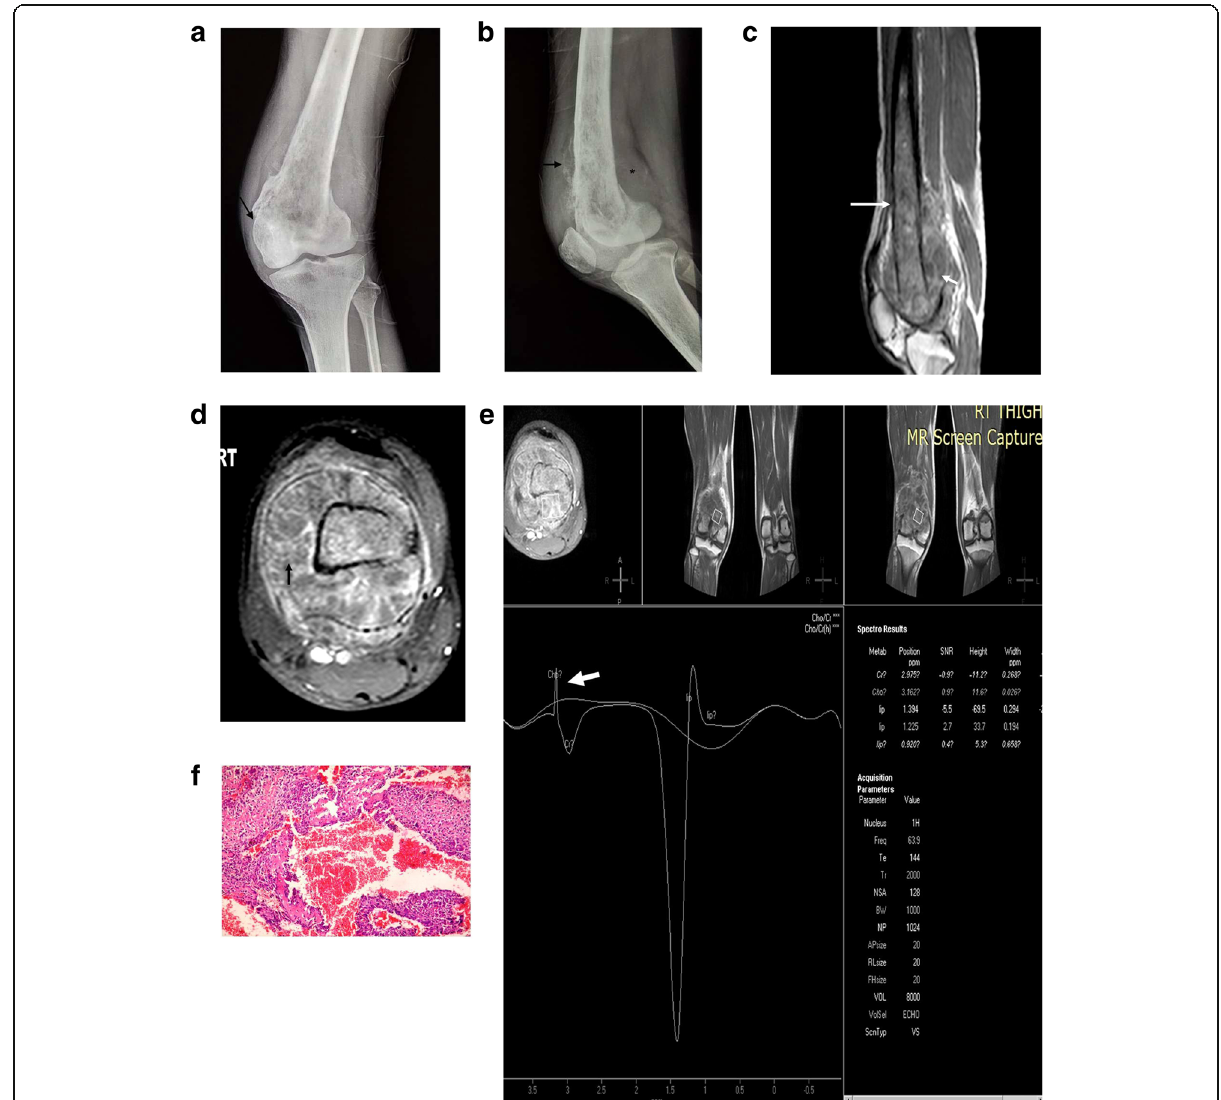
Fig. 2 An18-year-old male patient with swelling and pain right knee. a . AP radiograph of right knee. Permeative lysis is seen in the right distal femoral metaphysis with pathological fracture (arrow). b . Lateral radiograph of right knee. Interrupted type of periosteal reaction is evident with Codman ’ s triangle (arrow) and soft tissue component (asterisk). c . Post contrast T1 weighted sagittal image. Distal femoral metadiaphyseal destructive lesion with cortical erosion (long arrow) and soft tissue mass denoted by (short arrow). d . Post contrast fat saturated T1 weighted axial image. Thick irregular nodular enhancing septae (arrow), are seen interspersed with numerous non enhancing cystic areas. e . MRS shows small Choline peak at 3.2 ppm (arrow). f . HNE100X showing multiple cystic spaces containing blood lying by cyst wall showing presence malignant cells along with osteoid and giant cells suggestive of telangiectatic